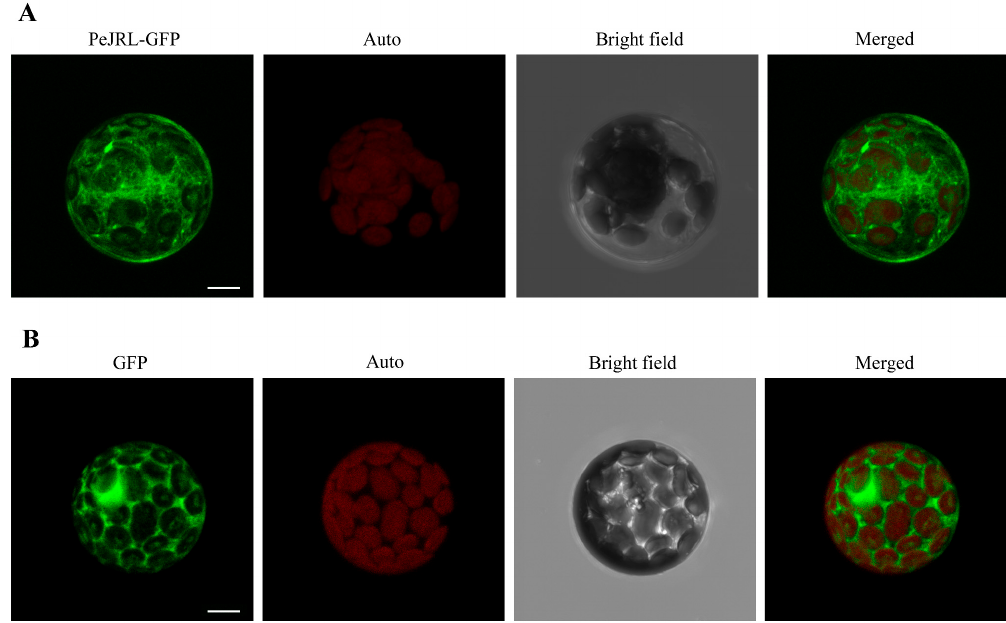
Figure 3. Subcellular localization of PeJRL by transient transformation in Arabidopsis mesophyll protoplasts. ( A ) Representative images of PeJRL-green fluorescent protein (GFP) in Arabidopsis protoplasts. ( B ) Control images for GFP vector. Green fluorescence was evenly detected in the cytosolic and nuclear spaces. Experiments were repeated four times with the same results. Scale bars = 5 µ m.